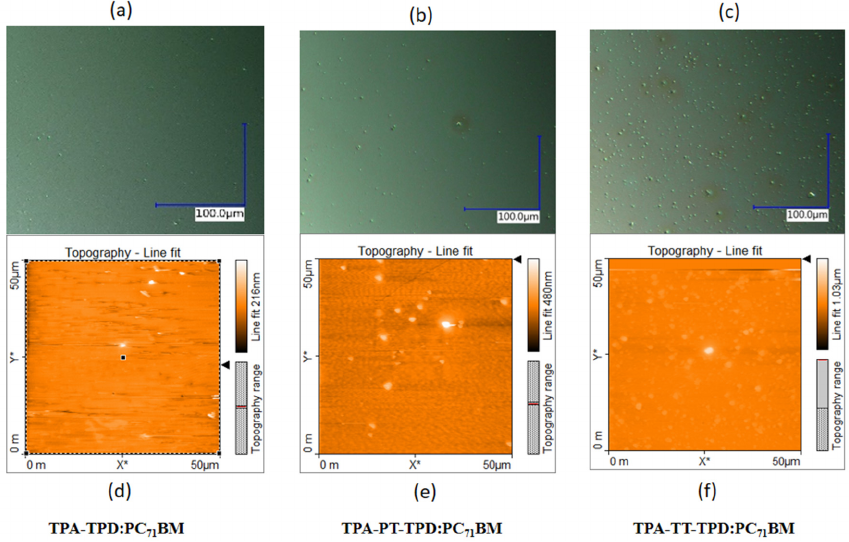
Figure 5. Images of SMs:PC71BM blended films prepared from CB onto ITO/PEDOT:PSS, with thermal annealing of 80 °C for 20 min, rations 1:4, 1:3 and 1:2 Donor-Acceptor for TPA-TPD , TPA-PT-TPD and TPA-TT-TPD , respectively: ( a – c ) are images from an optical microscope; ( d – f ) morphology images from atomic force microscopy